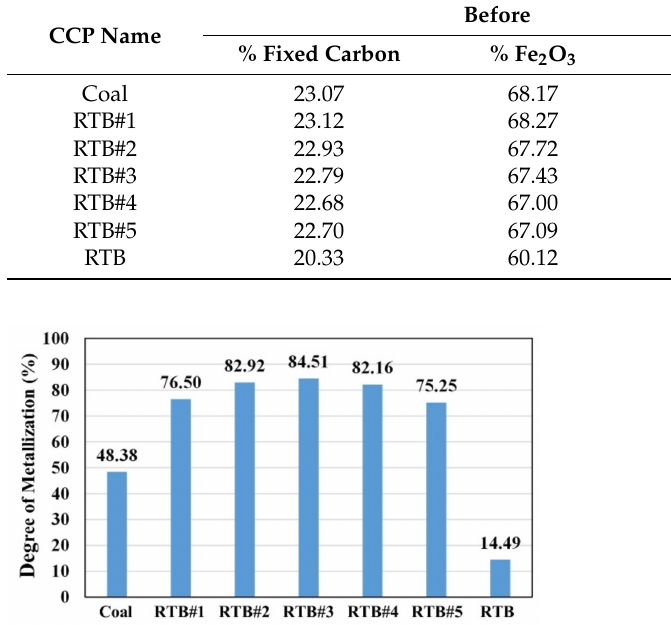
Figure 7. Degree of metallization (DOM) for all CCP samples. For coal, a small amount of reduced Fe droplets was seen in the first min of reaction and then no significant change was observed until 30 min with 23.05 wt.% of metallic Fe. This indicates the small extent of iron oxides reduction in mill scale by the coal with the DOM of 48.38%. In the case of RTB alone, the reduction of iron oxides was likely to be incomplete within 30 min and occurred with the lowest DOM of 14.49% only. The CCP was seen to collapse after the first minute of reaction. The residue with red and black color was seen in the crucible for over 30 min of reaction along with the tiny metallic Fe droplets (6.09 wt.%